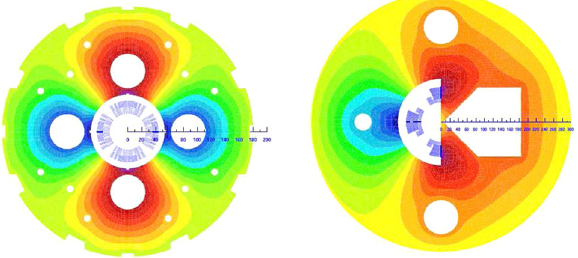
FIG. 3. Design of the half quadrupole for Q1 (right) and the normal quadrupole for Q2 (left). These magnets allowed a separation between the proton beams of 68 mm for the half quadrupole and of 87 mm for the normal quadrupole [13].